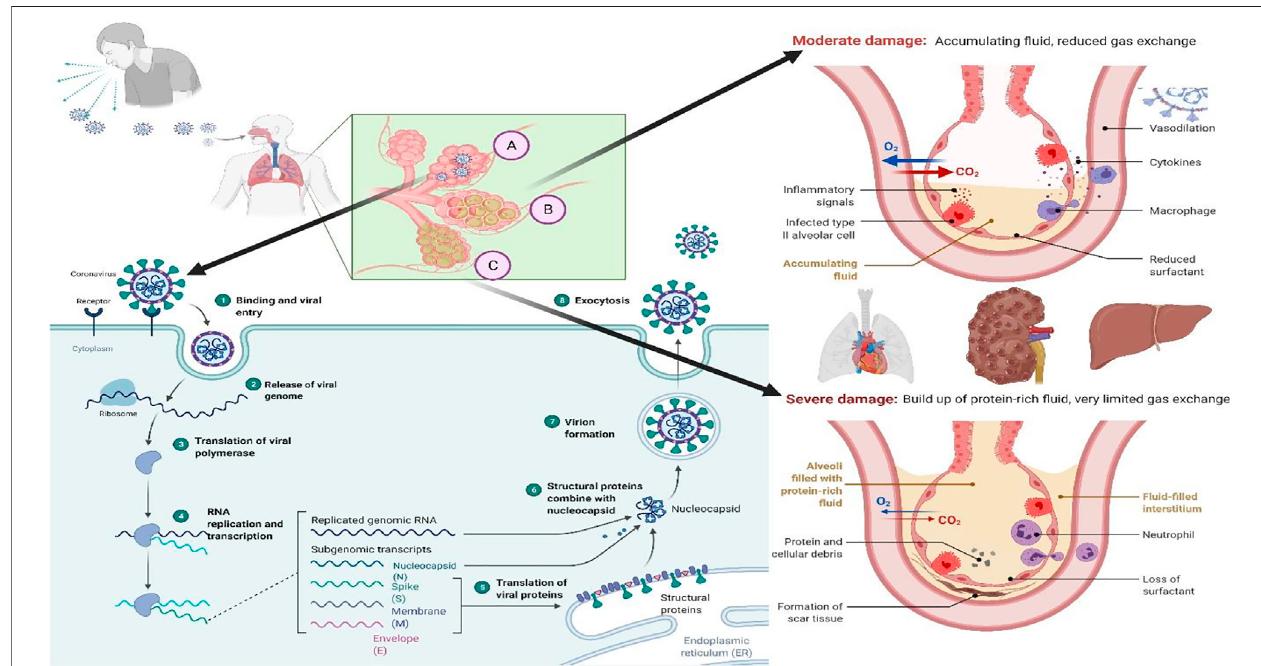
FIGURE 1 | “ The COVID-19 progression process in the host. (A) Viral replication in the lung epithelium: 1. Once the virus enters the respiratory tract, it binds to the ACE-2 receptorofthehostcell; 2.Binding leadstotheinternalizationofthevirusinsidethehostcellbyendocytosis andreleaseoftheviralgenome;3.Translationofviral polymerase; 4. RNA replication and transcription; 5. Translation of the viral proteins; 6. Structural proteins combined with nucleocapsid; 7. Viral assembly; and 8. Exocytosis of the virus particles. (B) As a result, the immune system attacks the infection site, killing healthy alveolar cells in the process. Reduced surfactant production by alveolar epithelial type II cells, combined with increased fl uid accumulation in the alveoli, results in decreased or hindered exchange of gases. (C) Once cytokinesareactivatedwithoutabreak,theycancausedamagetothecellsthatreacttothecytokinesandhaltorganfunction.Thisisreferredtoasacytokinestorm,and it is responsible for the transmission of severe diseases such as COVID-19 ”